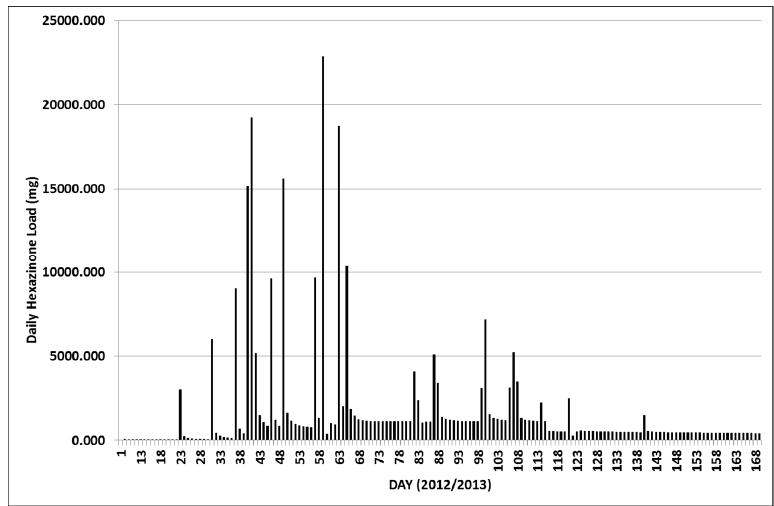
Figure 8. Year 1—modeled instantaneous concentrations of hexazinone in the Rangitaiki River at the Rangitaiki flow gauge.